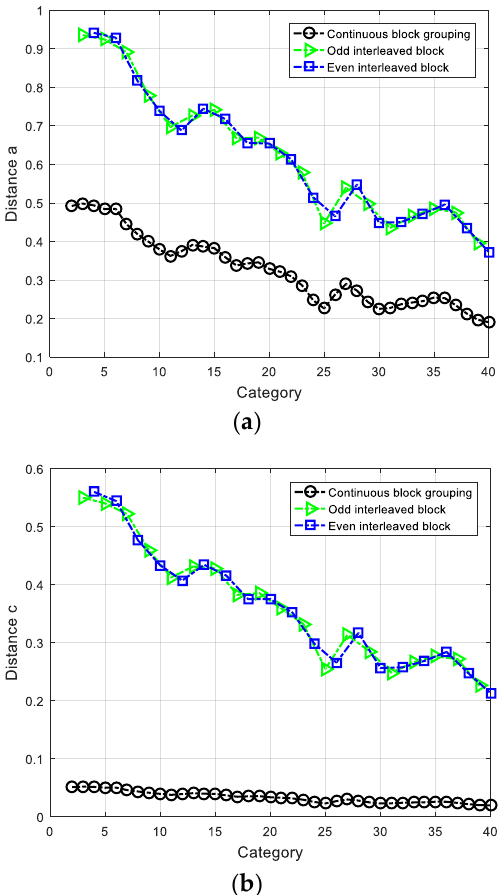
Figure 9. Discrimination of different dictionary compositions: ( a ) d istance 𝑎 for two dictionary compositions; ( b ) d istance 𝑐 for two dictionary compositions.